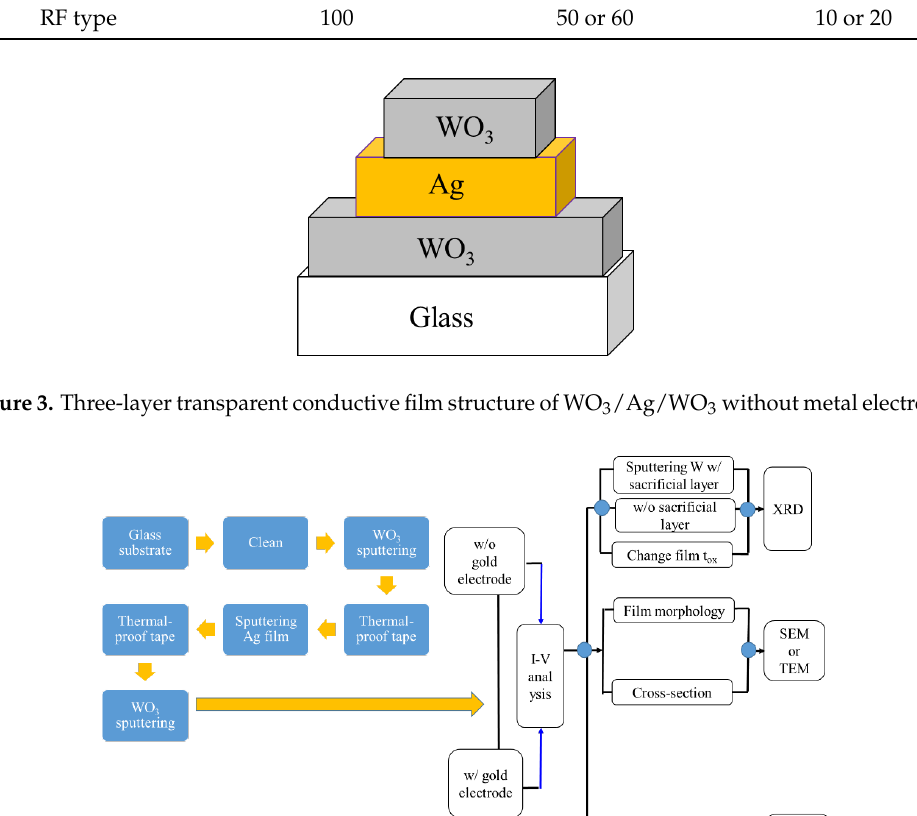
Table 1. Changeable sputtering parameters in this work.